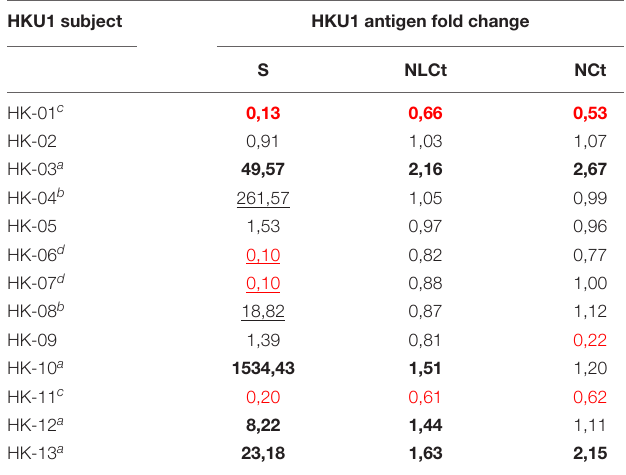
TABLE 1 | The V1-V2 antibody fold change values of individual HCoV-HKU1-infected-subjects assayed by HKU1 S, NLCt, and NLCt